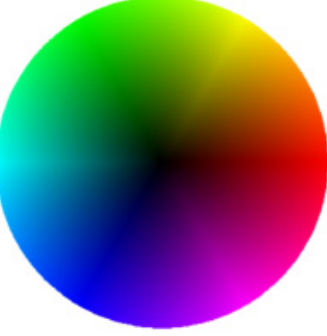
Figure 9. Optical flow representation. The color corresponds with the direction of the optical flow vector while the magnitude is encoded as the color